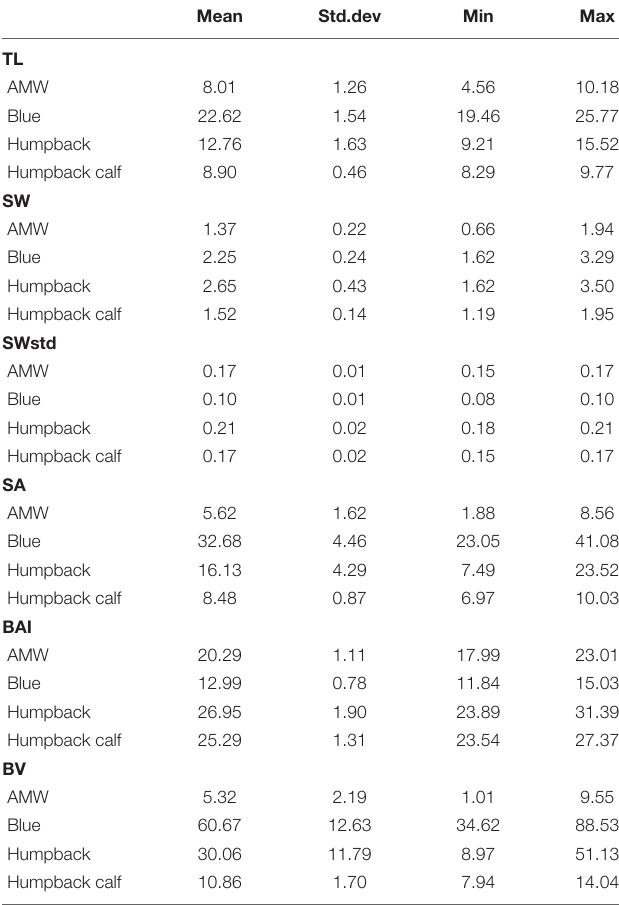
TABLE 2 | Summary of each body condition measurement for each species.